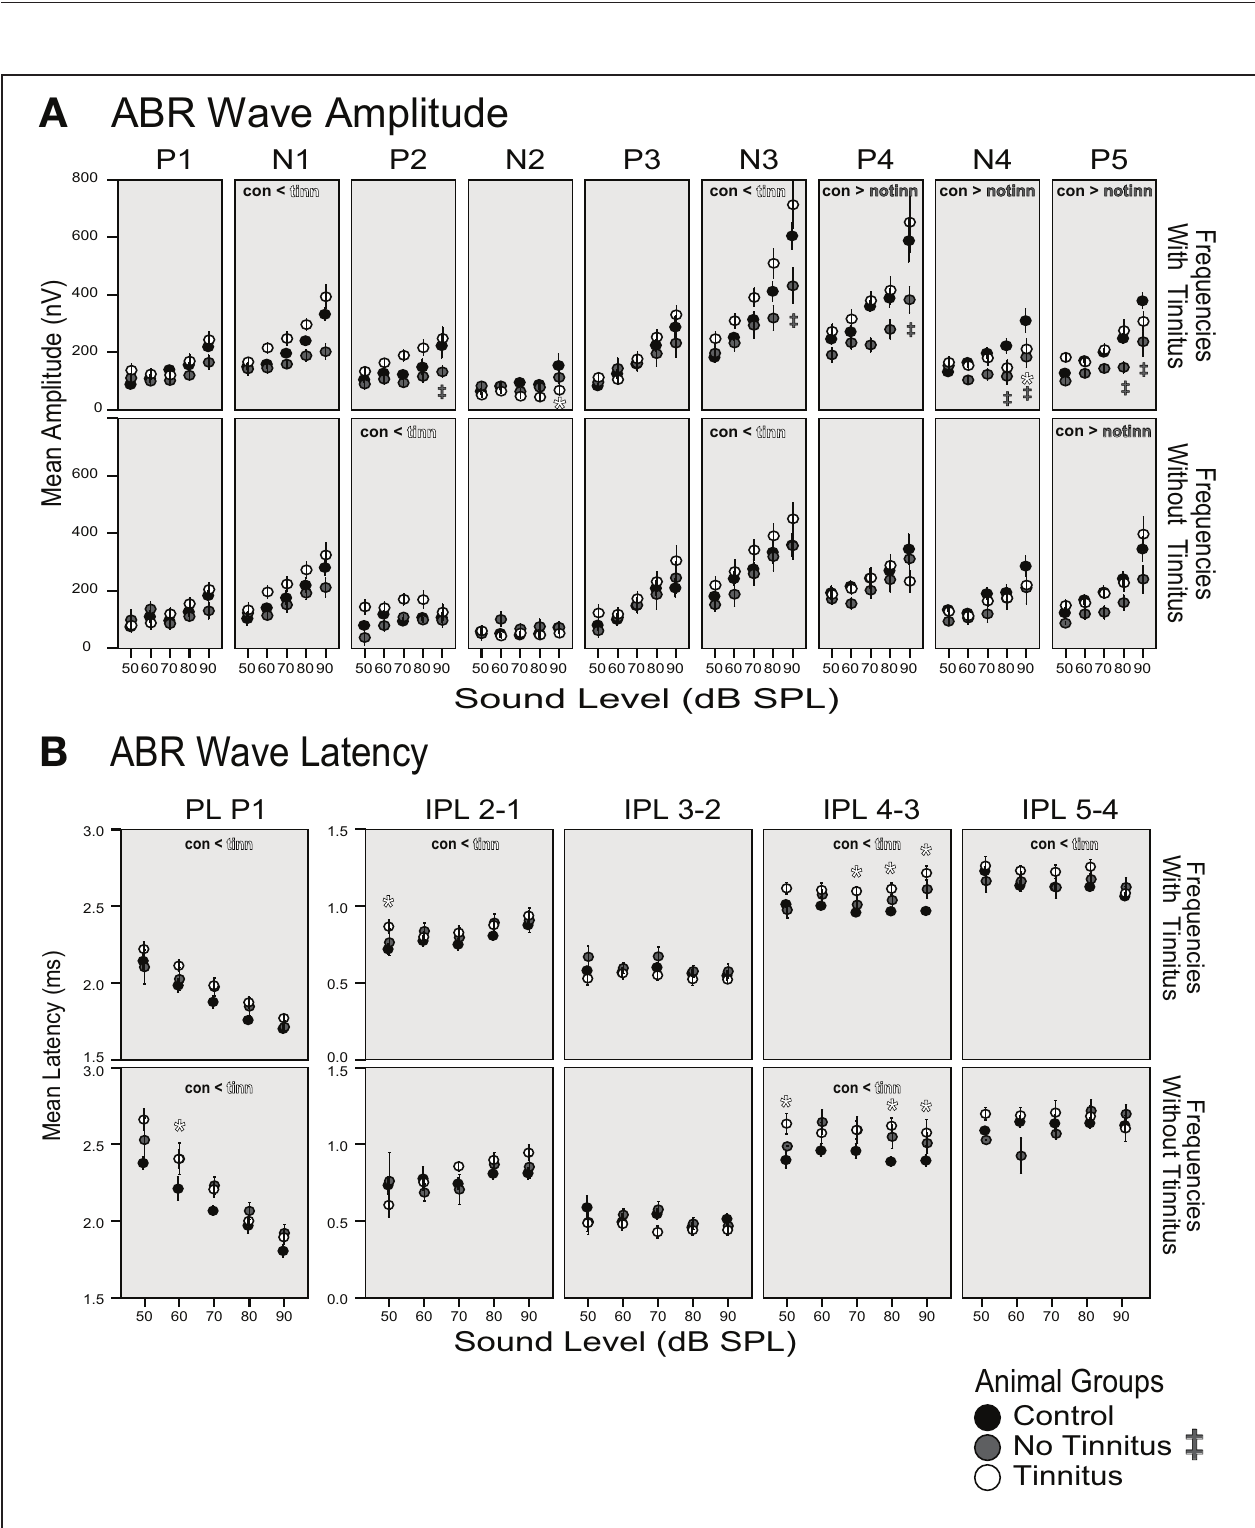
FIGURE 10 | (A) Amplitude and (B) latency of ABRs as functions of sound level. Data was averaged across frequencies “with tinnitus” according to the PPI tests (8, 9, 12, 16kHz; upper row panels in A and B) and “without tinnitus” (4, 6, 7kHz; lower row panels). The mean and standard error is shown for the group of control (black dots, n = 4 animals), no-tinnitus (gray dots, n = 3 animals) and tinnitus animals (white dots, n = 4 animals). Significant differences between groups for an ABR parameter are indicated